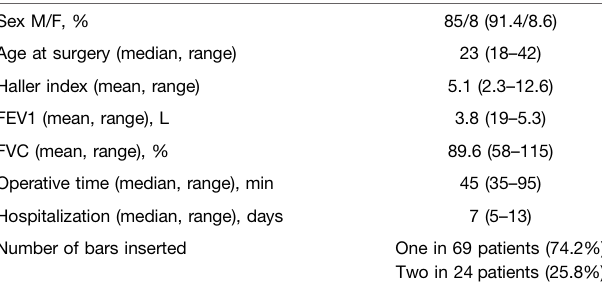
TABLE 1 | Patients ’ characteristics and perioperative course.